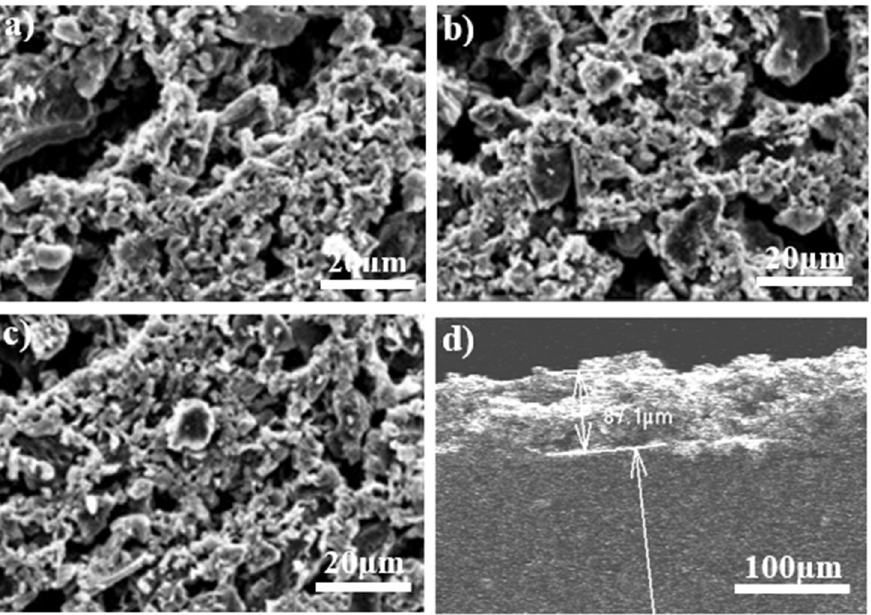
Figure 2. SEM images of top view of electrodes with ( a ) 200 μ m, ( b ) 400 μ m and ( c ) 600 μ m initial thicknesses. ( d ) Cross-section view of an electrode of 200 μ m initial thicknesses. thicknesses. ( d ) Cross-section view of an electrode of 200 µ m initial thicknesses. Table 1. Comparison between initial film thickness and measured thickness, specific capacitance and effective mass of the active material on the electrode for various electrode thicknesses.